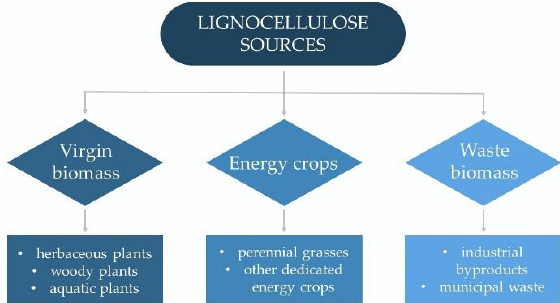
Figure 4. Sources of lignocellulosic biomass for bioethanol production.